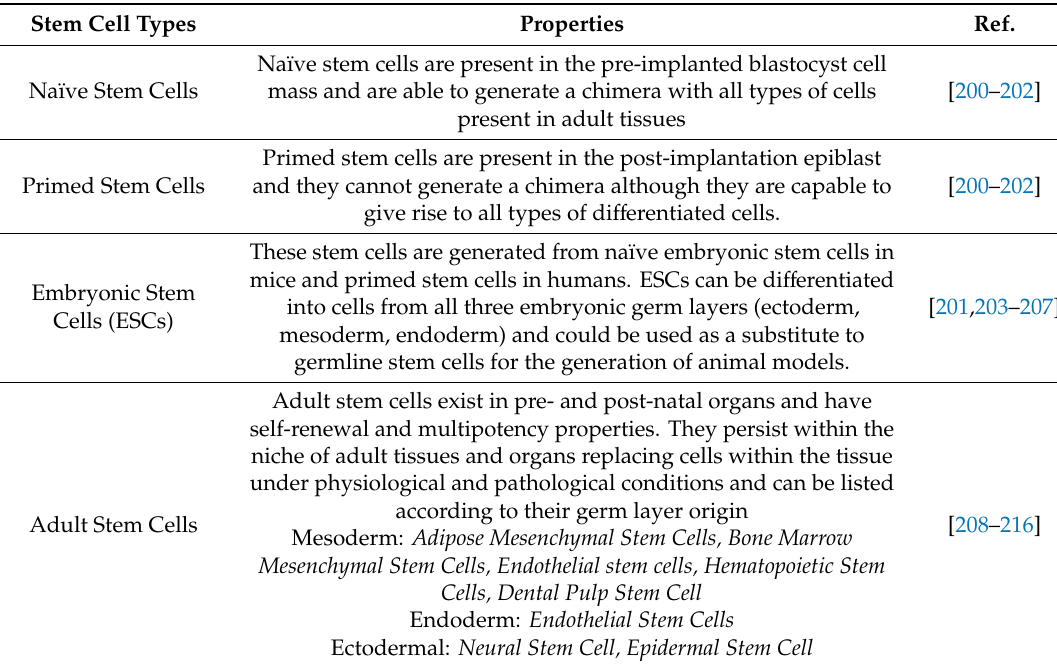
Table 3. Stem cells types and